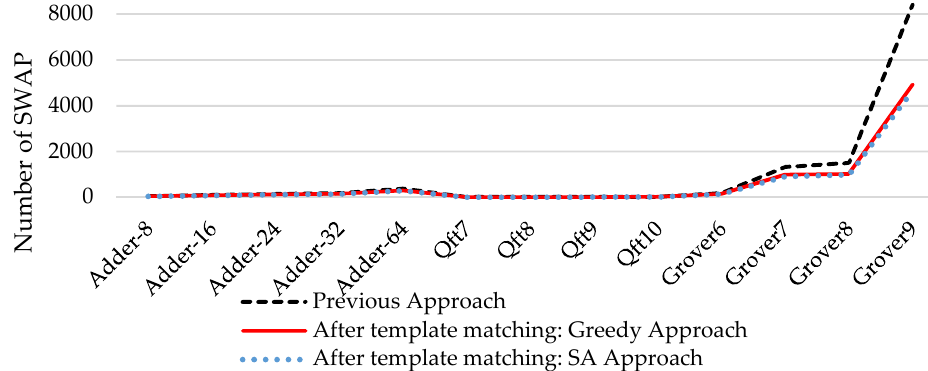
Figure 4. The behavior of the number of SWAP gates obtained by using two different approaches in accepting or rejecting substitutions.